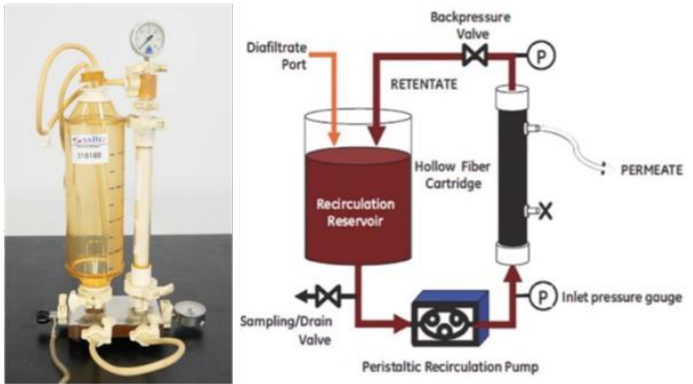
Figure 4. Benchtop ( left ) and schematic diagram of the experimental setup. Peristaltic pump ( right